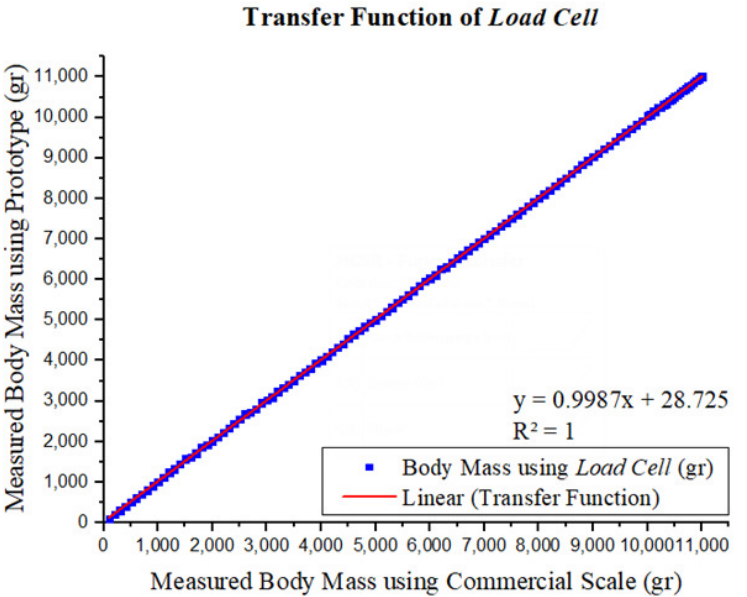
Figure 4. The graph of transfer function illustrates a comparison between the output of the load cell sensor and the commercial scale (floor scale). The slope value of 0.9987 means that the load cell sensor has high sensitivity, so the sensor output is proportional to the digital scale output. Afterward, optimization of the position of the load cell sensor was carried out. The load cell sensor was mounted on a board measuring 30 cm × 30 cm × 1.7 cm, and a plate mass of 21,254 gr was used as the value of the calibration factor, as shown in Figure 5. In order to determine the most optimal sensor position, five samples with different masses were used, and measurements were carried out with ten repetitions.